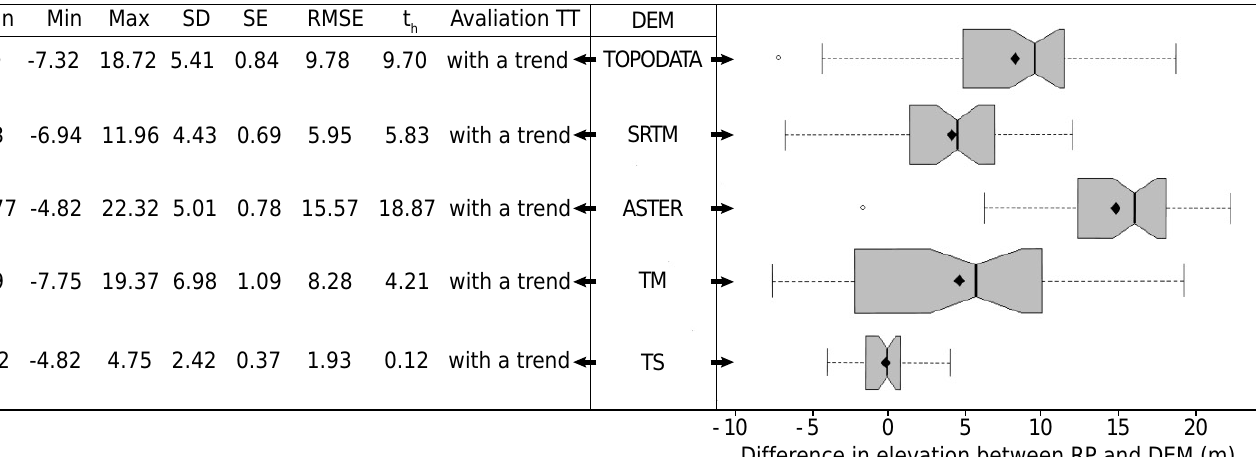
Figure 4. Descriptive statistics of elevation error values (EE) represented by the boxplot, value of root mean square error (RMSE), t h value (calculated by the Student’s t test) result and the trend test (TT) based on the t h value for the five